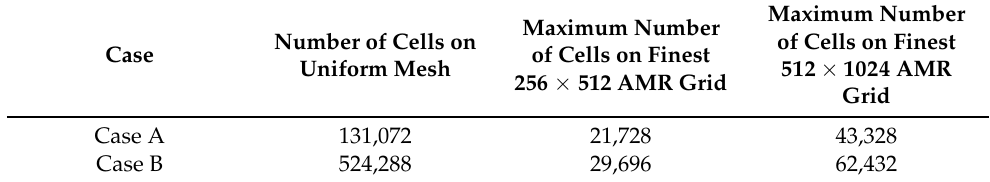
Table 2. Number of cells on a uniform mesh and maximum number of cells on different AMR grids.